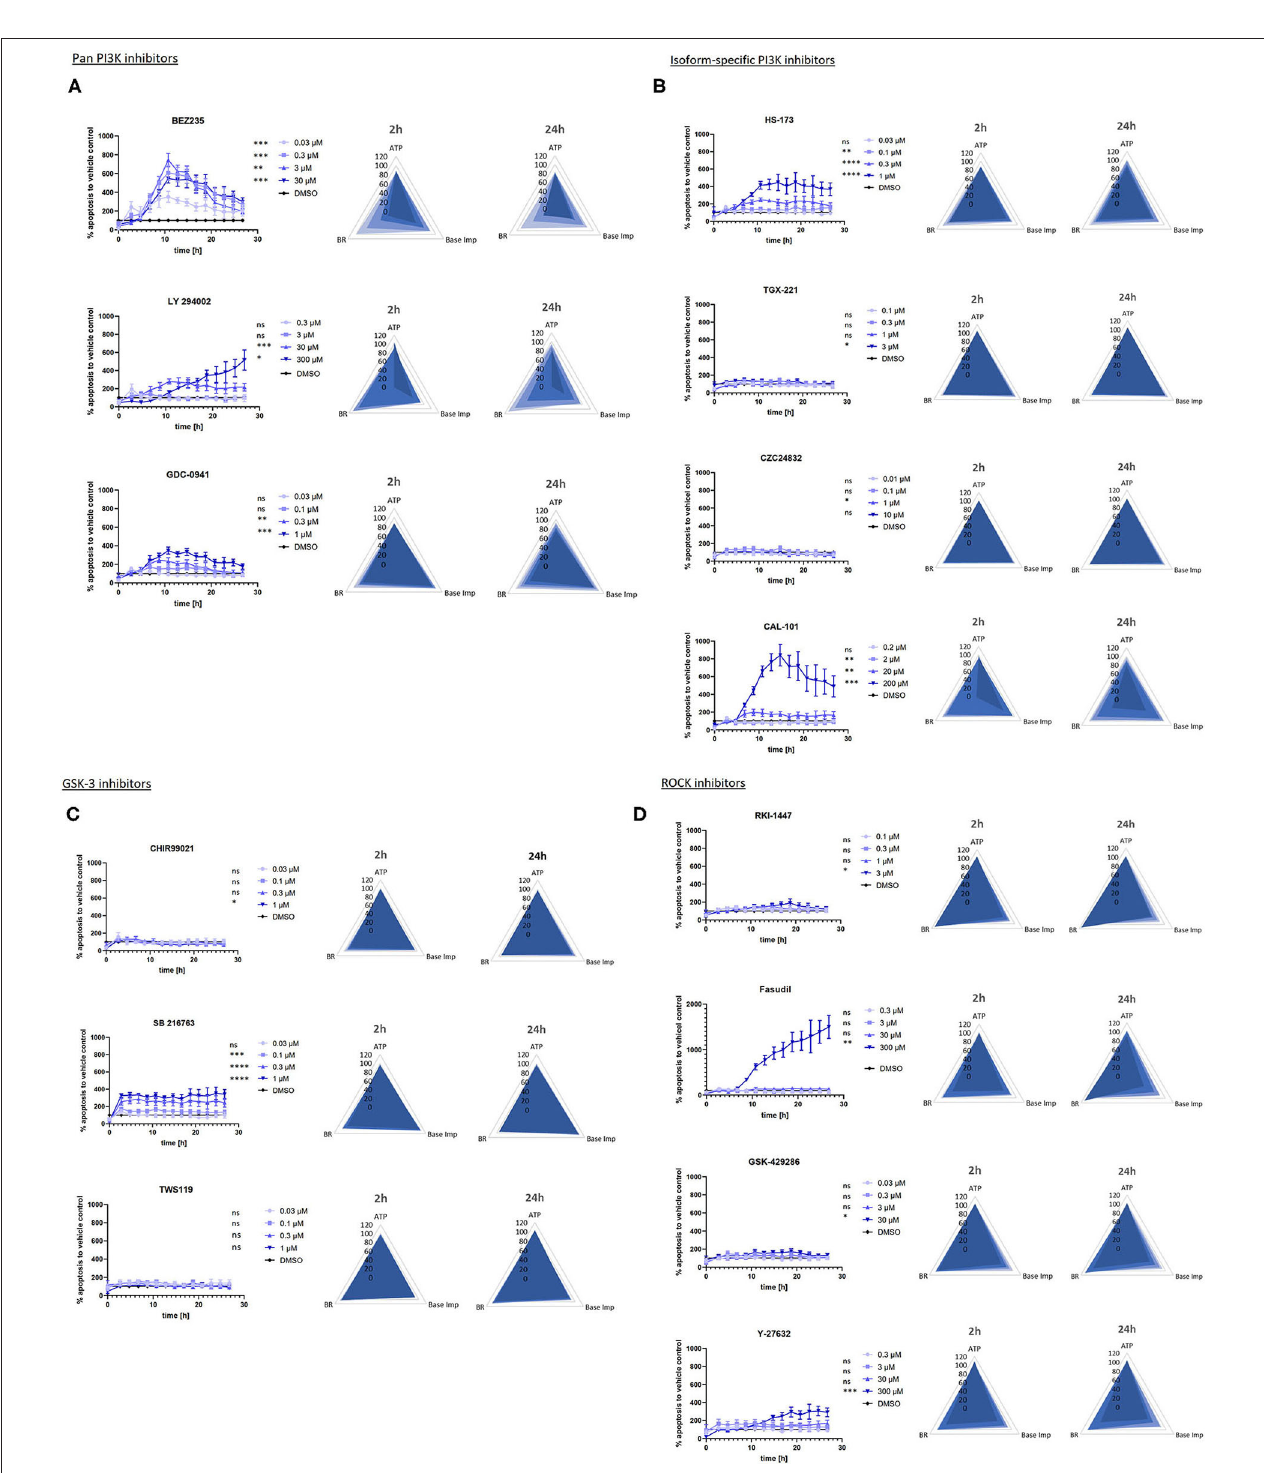
FIGURE 2 | Graphs of apoptosis kinetics and radar plots for beating rate, base impedance and ATP measured in the hSC-CMs treated with SMKI. (A–D) show the results for the PI3K-pan, PI3K isoform-specific, GSK-3 and ROCK kinase inhibitors, respectively. The data represent the average of 3–5 repeats for each time point. The apoptosis graphs show mean + /- SEM of kinetic data sampled every 2h after the addition of compounds. The fractional change from baseline determined for each concentration is compared to that of vehicle control (DMSO). The significance is indicated by asterisk (or ns for p > 0.1) next to the specific concentration in the graph legends: * p < 0.1, ** p < 0.01, *** p < 0.001, **** p < 0.0001. Two-dimensional radar charts present multivariate drug-induced functional profiles in hSC-CMs. They display fractional change from baseline in beating rate, base impedance and ATP content across ascending concentrations of drugs after the short- (2h) and long-term (24h)